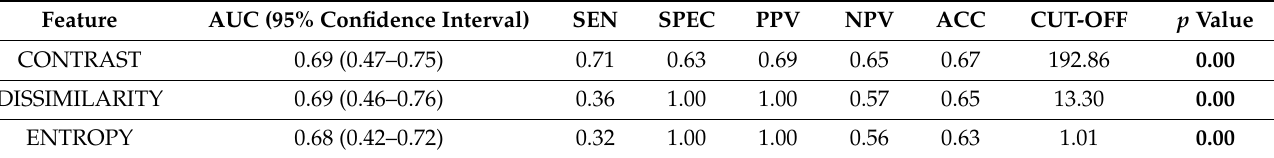
Figure 2. Boxplot for texture features to detect RAS mutation. Table 5. Diagnostic accuracy for the individuated significant features to detect RAS